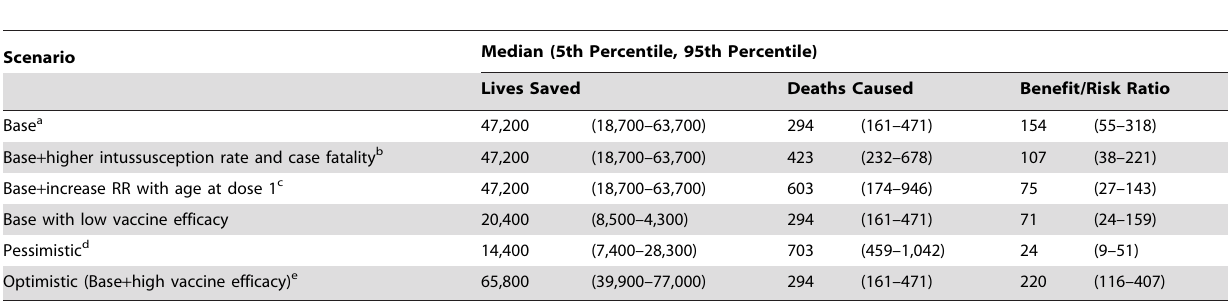
Table 5. Additional lives saved versus deaths caused by loosening the age restrictions for rotavirus vaccines in WHO high and very high mortality group.